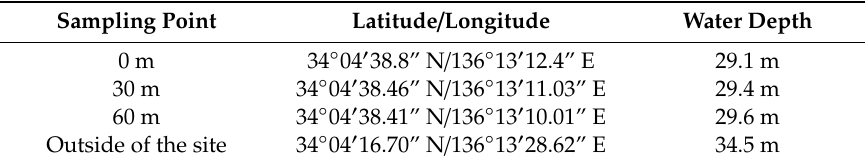
Table 3. Information about sampling points.